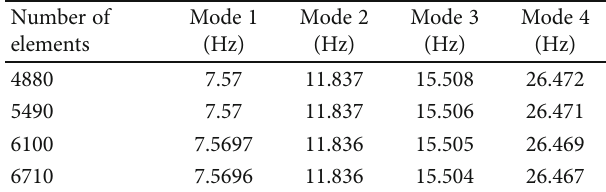
Figure 5: Natural frequencies of the blade ( Λ = 15 ° ). Table 3: Natural frequency of hingeless rotor blade ( AR = 18 : 07